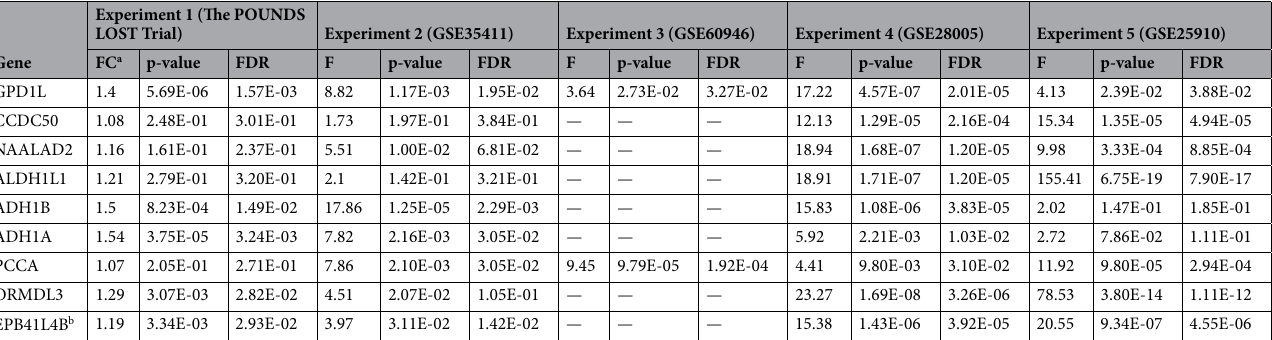
Table 3. The results of five experiments for hub genes in the Yellow module. “—” Gene was not measured by the RT-qPCR in the GSE60946. a FC, Fold change (Weight loss vs. Baseline). b One of 97 BMI loci identified by